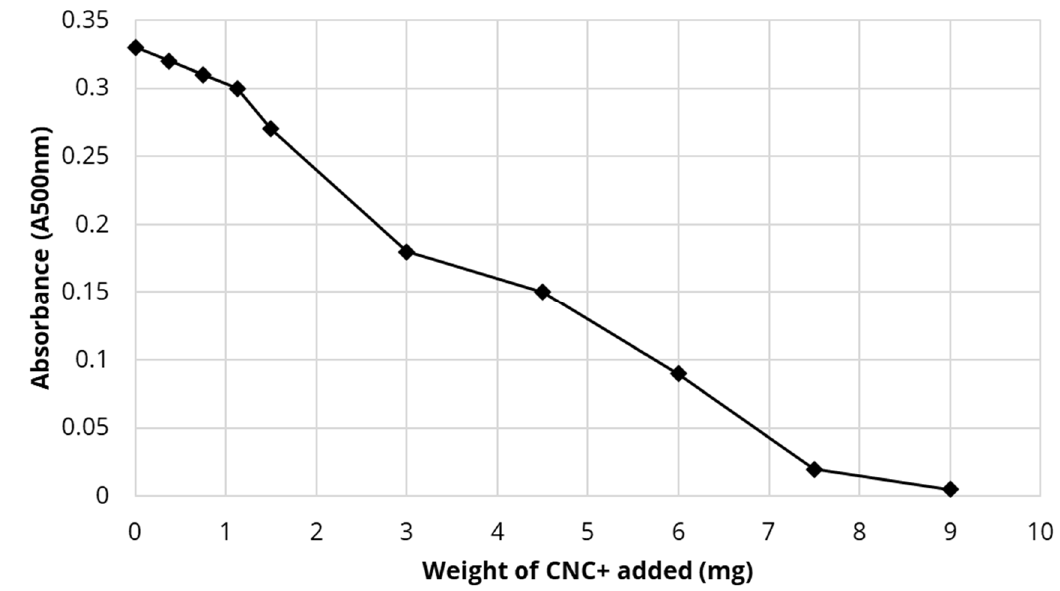
Figure 10. Flocculation of Cloisite clay (20 mg) by CTAC-CNC. Turbidity absorbance at 500 nm after mild centrifugation.